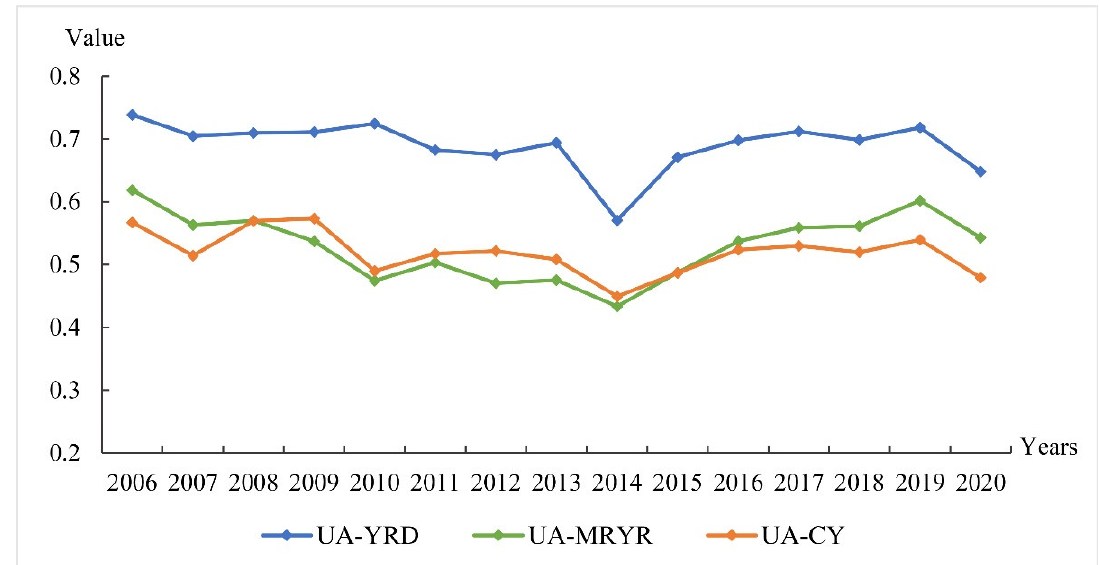
Figure 3. Temporal changes of ULEE in the three major urban agglomerations, 2006–2020.